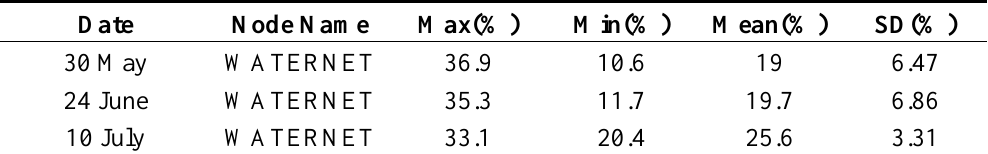
Table 1. Summary of WSN data used in the